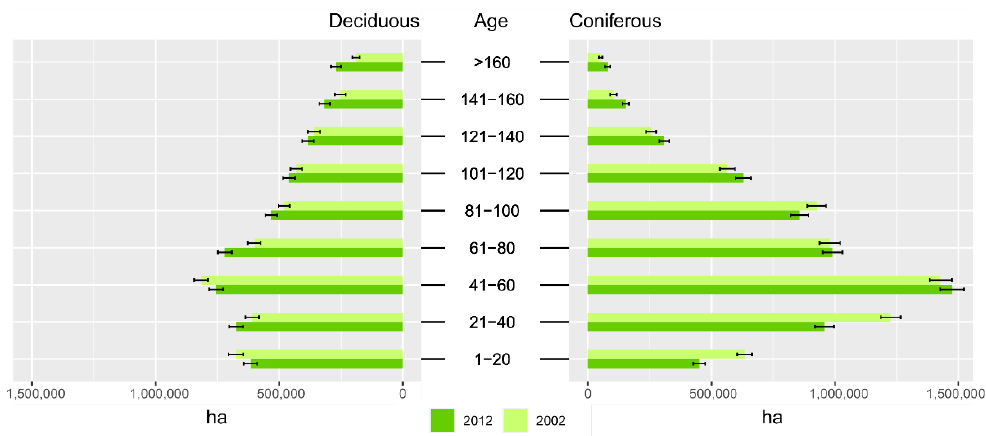
Figure 5. Age structure of German forests as recorded in the last two inventories (2002 and 2012). Age is given in years. Error bars (1 standard error) are depicted in black.